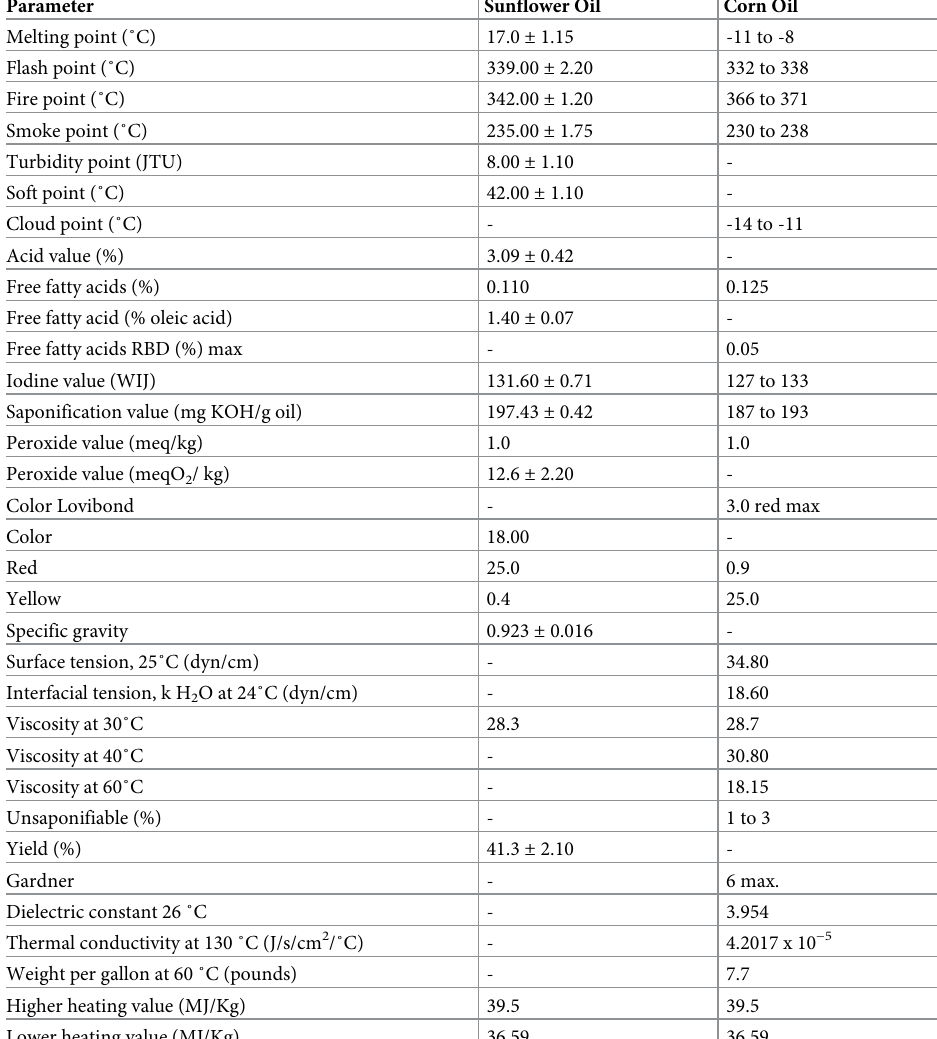
Table 2. Physiochemical properties of sunflower oil and corn oil [40–46]. Mean ± standard deviation of triplicate